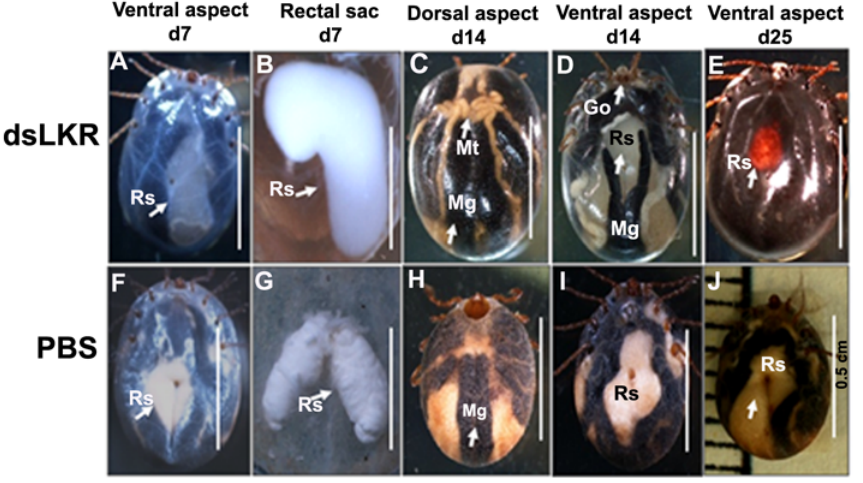
Figure 10. Morphological changes in LKR silenced ticks. The macrophotographs of dsLKR RNA-injected tick (above) and PBS-injected tick (below). A, Ventral aspect of dsLKR RNA-injected ticks 7 days after engorgement, Rs, rectal sac (arrow). B, Magnification of A and rectal sac of dsLKR RNA-injected ticks show significant enlargement due to filling with fluid; C and D , Dorsal and ventral aspects of dsLKR RNA-injected tick 14 days after engorgement,show edema-like condition and hernia-like protrusion of Gene’s organ. Mg, midgut; Mt, Malpighian tubule, Rs, rectal sac; Go, Gene’s organ; E, Ventral aspect of dsLKR RNA-injected tick 25 days after engorgement, Rs, rectal sac changed color from white to red (arrow); F to J; PBS- injected tick. F, Ventral aspect of PBS-injected tick 7 day after engorgement; G, Magnification of F and rectal sac; H, Dorsal aspect 14 days after engorgement; I, Ventral aspect 14 days after engorgement; J, tick after egg oviposition 25 days after engorgement. doi:10.1371/journal.pone.0007136.g010 midgut, salivary gland, fat body and synganglion during blood feeding in adult ticks. However, the LKR/SDH mRNA was consistently expressed at the same levels in the ovary and hindgut with Malpighian tubules ( Figure 2B ), and protein expression was higher in the ovary than other organs ( Figure 5B ). The high